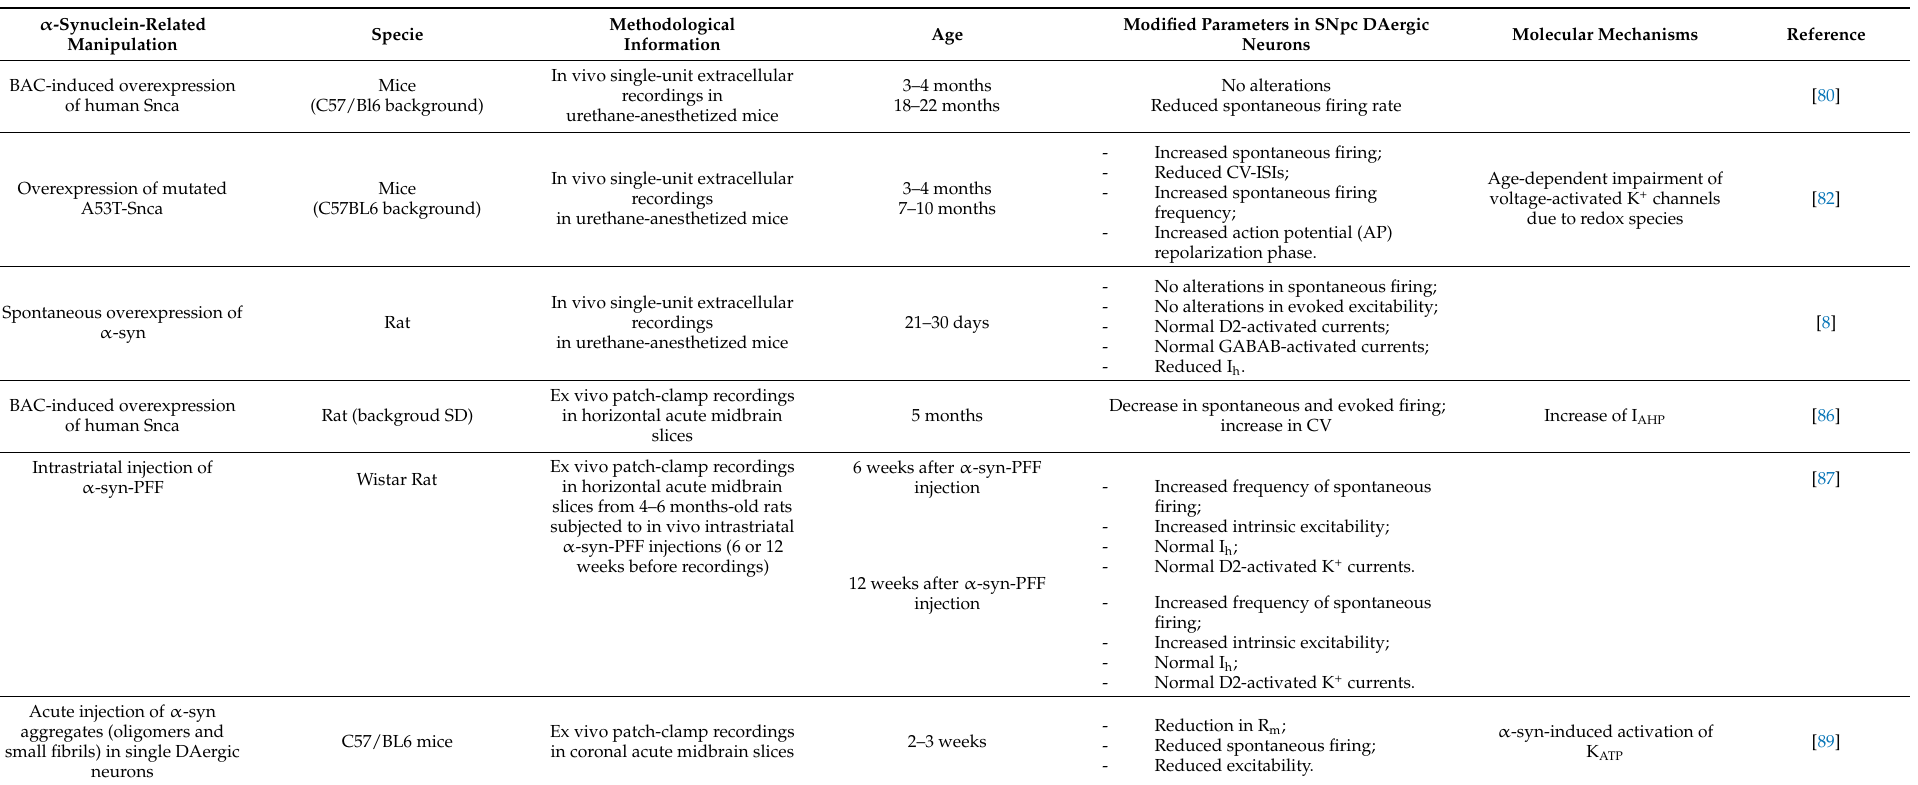
Table 4. Summary of the principal findings of the cited literature on α -synuclein-dependent effects on SNpc DAergic neuron functional